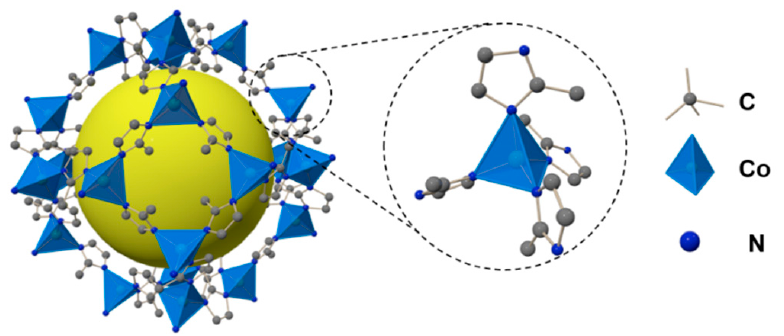
Figure 2. A structure diagram of ZIF-67-based EMOFs.